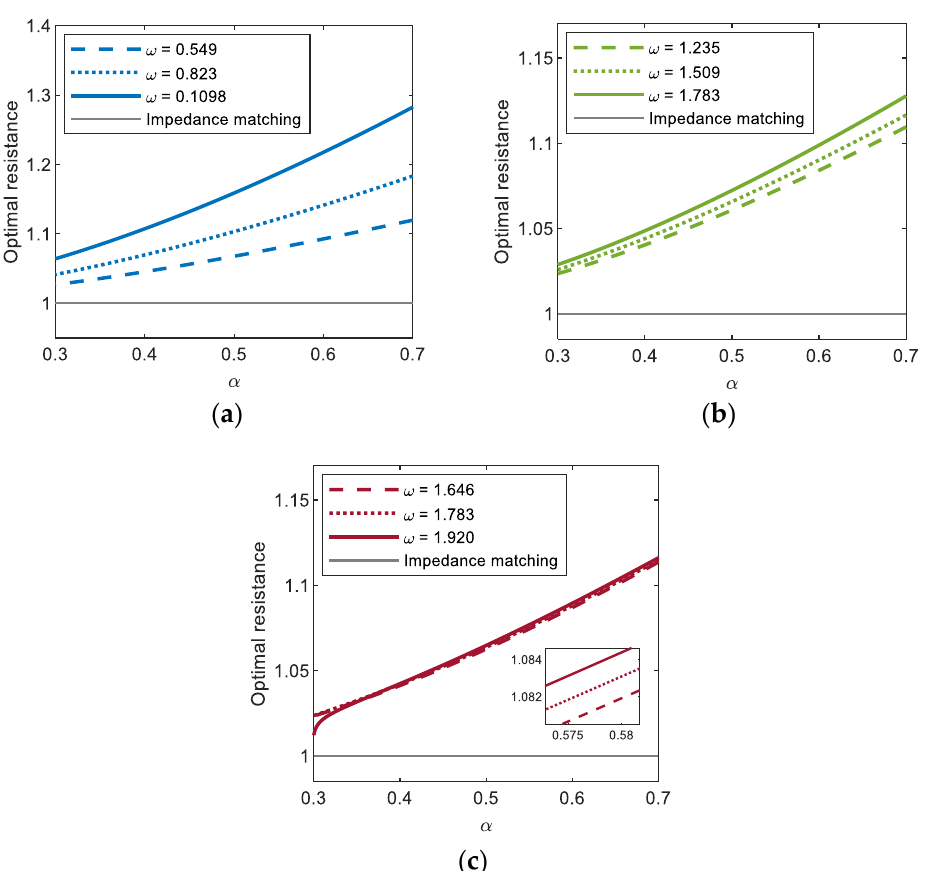
Figure 8. Plots of the resonant inductive reactance versus the optimal load resistance for ( a ) period-1 T , ( b ) period-3 T , and ( c ) period-5 T motions of the electromagnetic energy harvester. For each motion (colored thick lines), the results are calculated by using the semi-analytic method, with three different values of excitation frequency and a constant base acceleration of 0.02, and compared with that obtained by the resistance-matching technique (grey thin line).